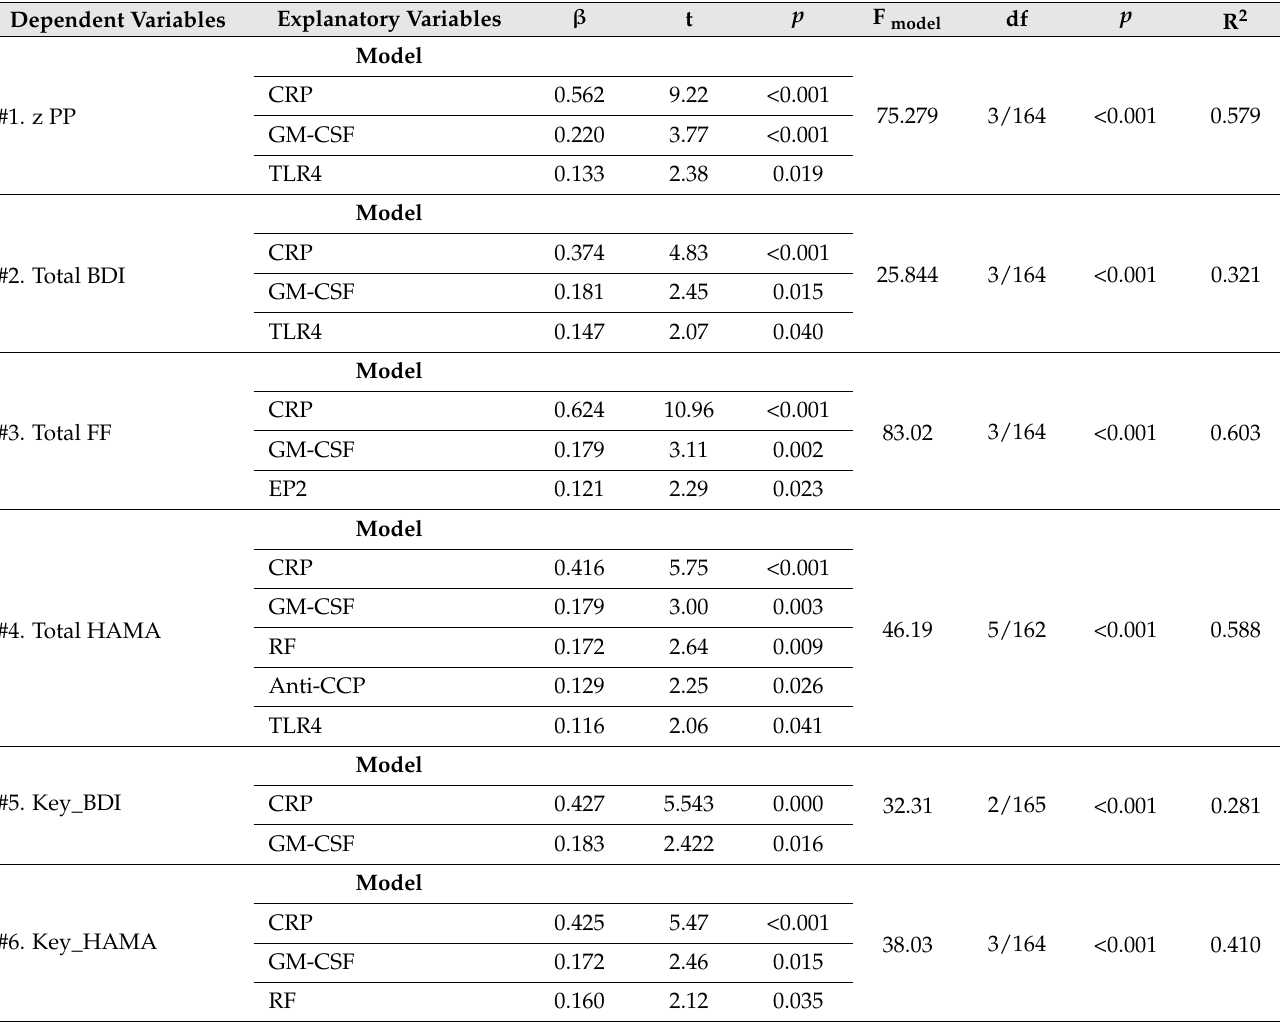
The correlations between the psychiatric rating scale scores and the severity of RA in the entire study group ( n = 168) and the restricted group of RA patients ( n = 118) are pre- sented in Table 6. The total BDI, FF, HAMA scores, and z PP scores were significantly and positively correlated with the DAS28-4, CDAI, SDAI, TJCs and SJCs, PGA, and EGA.